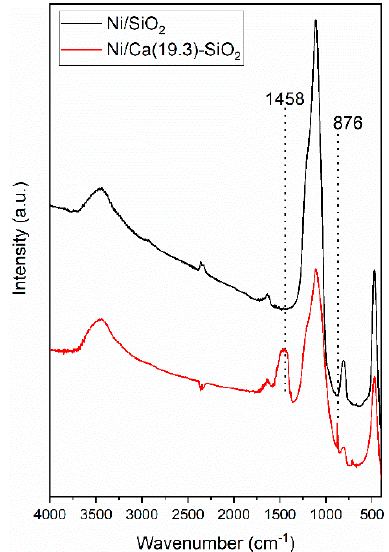
Figure 2. Fourier transform infrared spectroscopy (FTIR) spectra of reduced Ni/SiO 2 and Ni/Ca(19.3)- SiO 2 catalysts.